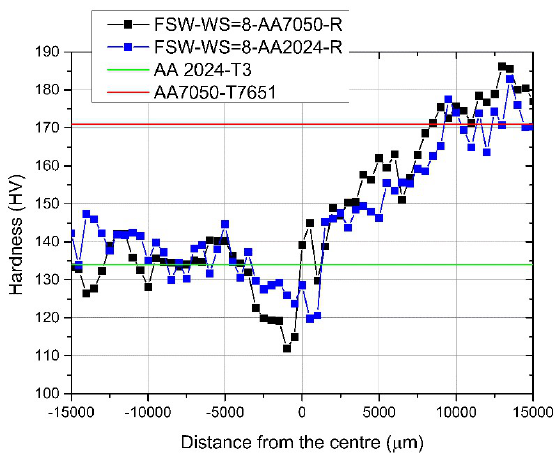
Figure 11. Microhardness test results for WS = 8 mm/s and the different positioning of the materials.